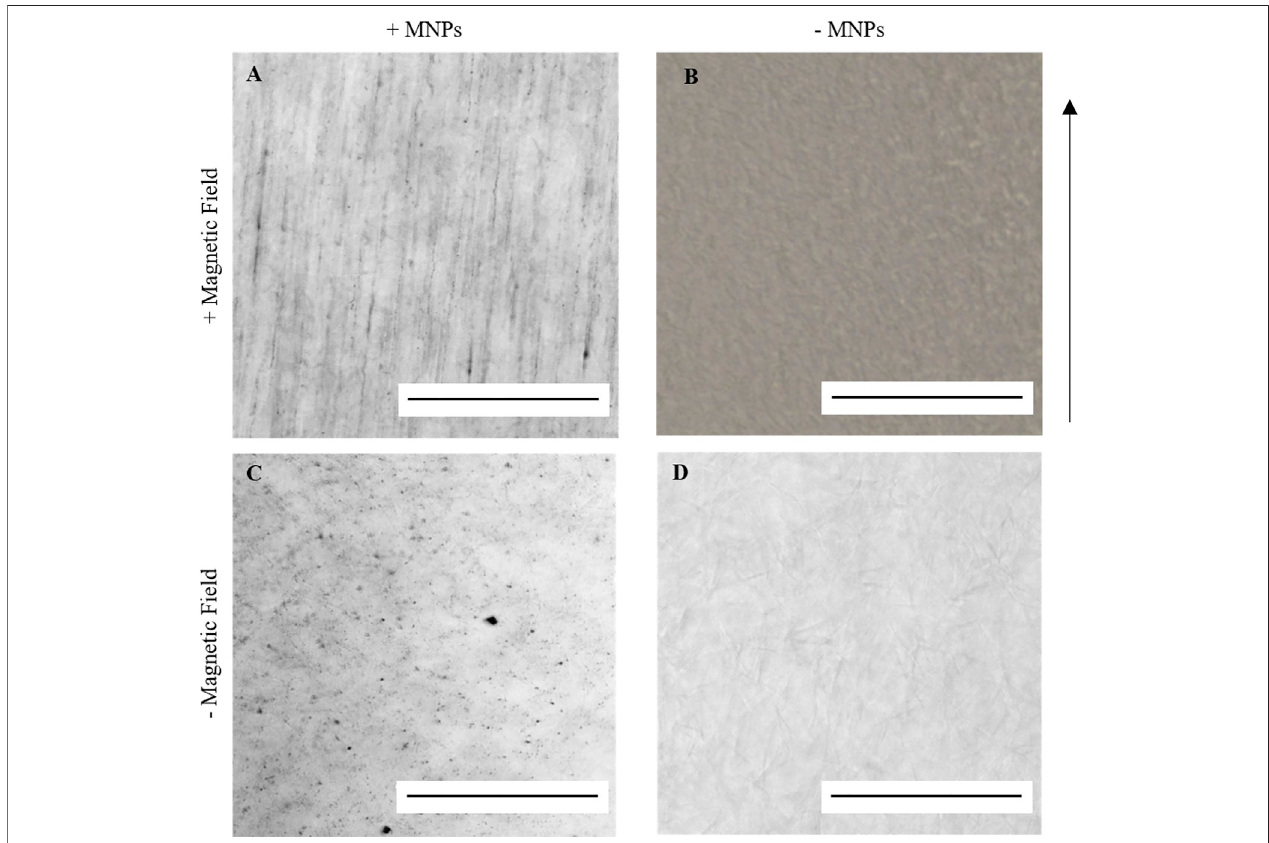
FIGURE 2 | Light microscopy imaging of 0.5 μ g/ μ l 250 nm dextran-coated MNPs in 100 μ l 3 mg/ml collagen I gels. A and C = MNP-laden gels; B and D = gels withoutMNPs.Whengelledinthepresenceofanexternalmagnetic fi eldat37 ° Cfor30 min,string-likestructurescouldbeidenti fi edinMNP-ladengels (A) butnotinnon- magnetic gels (B) . When gelled at 37 ° C without the application of the magnetic fi eld, these structures could again not be identi fi ed (C,D) . Scale bar = 0.5 mm, magni fi cation = ×20, arrow = direction of magnetic fi eld, and n = 3.